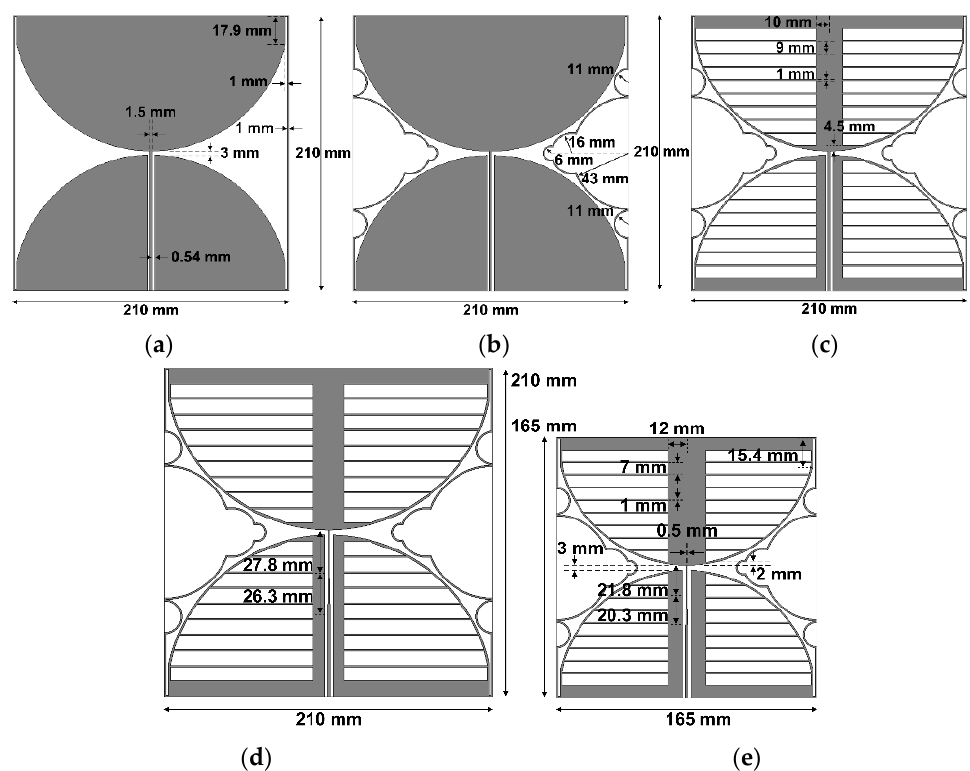
Figure 2. Antenna geometries considered in the design procedure for the proposed antenna: ( a ) the original CPW-fed wideband square loop antenna; ( b ) the original antenna with a multiple half-circular-ring-based loop structure; ( c ) the original antenna with the multiple half-circular-ring-based loop structure and horizontal slits; ( d ) a tapered CPW line-fed original antenna with the multiple half-circular-ring-based loop structure and horizontal slits; ( e ) the proposed miniaturized wideband loop antenna.